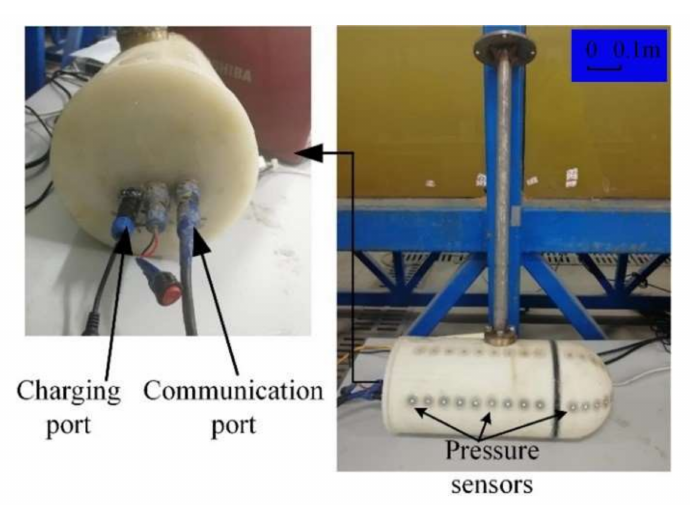
Figure 12. 3D picture of the carrier.